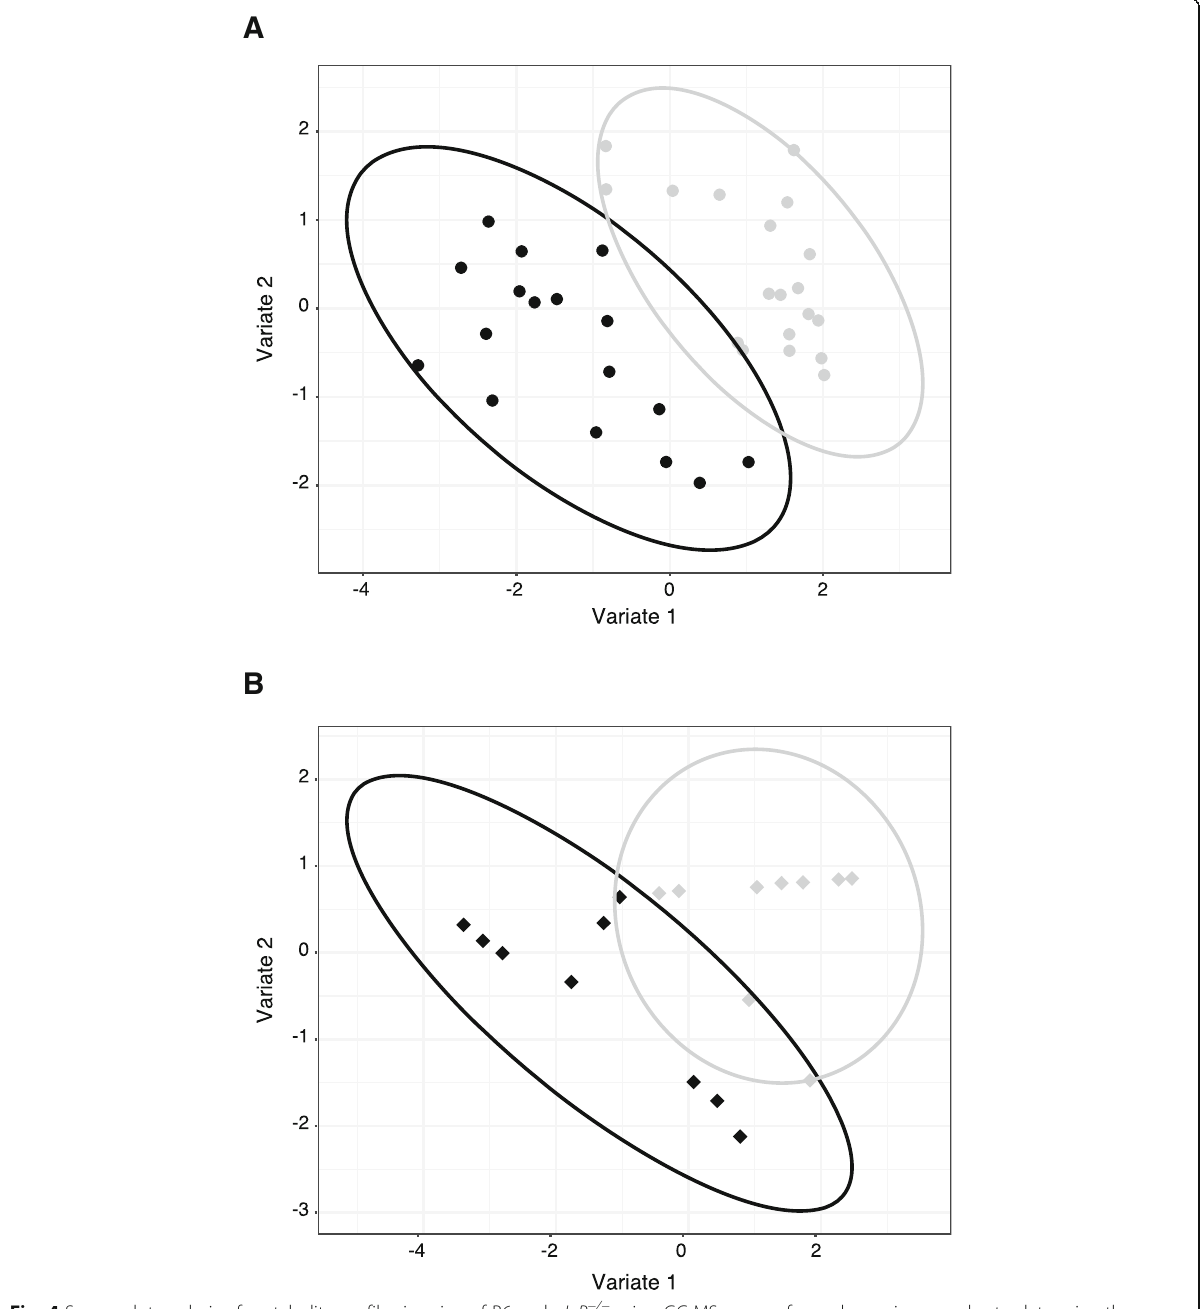
Fig. 4 Scores plot analysis of metabolite profiles in urine of B6 and pIgR − / − mice. GC-MS was performed on urine samples to determine the profile of metabolites excreted in the urine of a male and b female B6 and pIgR − / − mice. To control for sample variation due to urine volume and concentration, the annotated urine metabolites were normalized by Mean Absolute Deviation (MAD). Data was analyzed by sPLS-DA and scores plot, with 95% confidence intervals of the sample space highlighted by elliptical